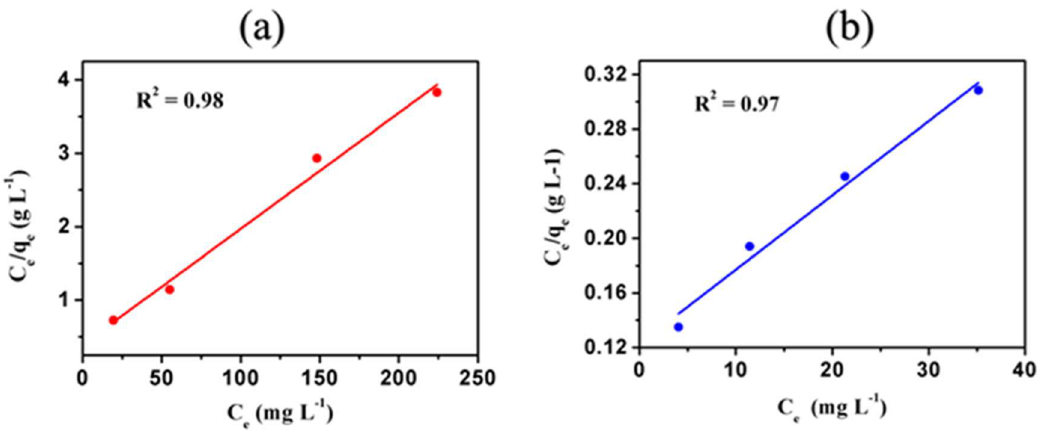
Figure 5. Langmuir isotherms of ( a ) Ni 2 + and ( b ) Cd 2 + by hematite nanoparticles. Langmuir adsorption isotherm constants of Ni 2 + and Cd 2 + ions adsorbed onto hematite nanoparticle.